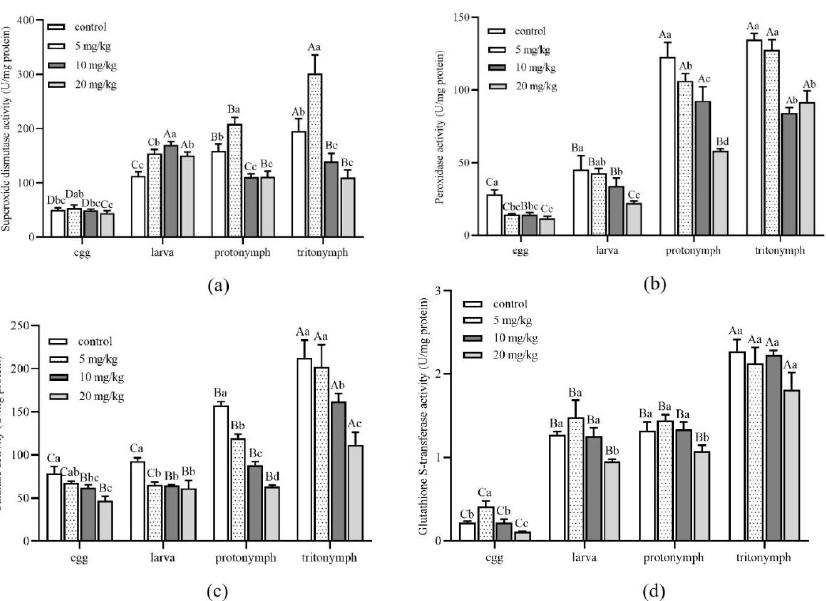
Figure 4. Detoxification enzyme activity of Aleuroglyphus ovatus under different concentrations of Cd stress at different immature development stages. ( a ) Activity of superoxide dismutase (SOD); ( b ) Activity of peroxidase (POD); ( c ) Activity of catalase (CAT); ( d ) Activity of glutathione S-transferase (GST). Results are expressed as mean ± SD. Different uppercase letters indicate significant differences among major immature development stages at the same Cd concentration ( p < 0.05). Different lowercase letters indicate significant differences among control and treatment groups at the same development stage ( p < 0.05).